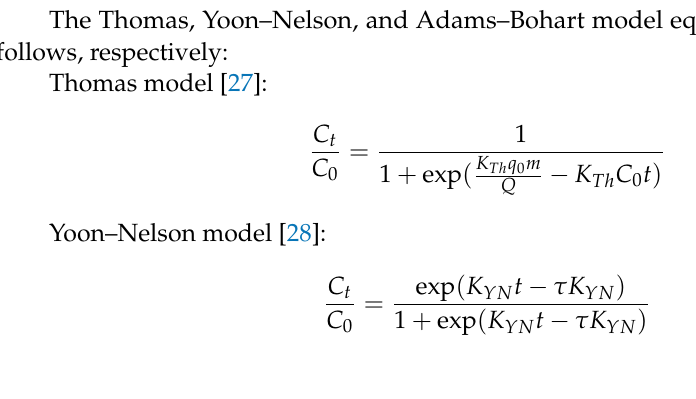
Figure 7. Breakthrough curve for calcium ions adsorption by RMCRs fixed columns.